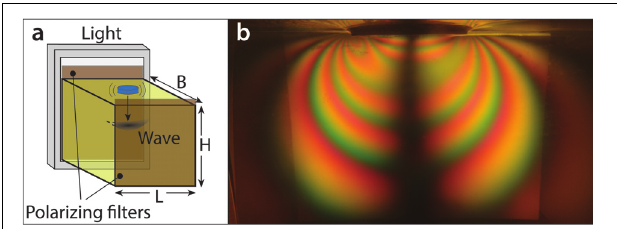
FIGURE 1 | (a) Experimental setup. We arrange a block of gelatin with a set polarizing filters, one in front and one behind the block of gelatin. Light passes through the setup and the deviatoric stresses become apparent. We used tanks of different shapes and dimensions, indicated below in the methodology section. A small plastic disk (blue object) is placed on the surface and struck to generate shear waves from the same location each time. (b) The photoelastic behavior of gelatin. In this example, a surface load generates a deviatoric stress field, which appears as a repeating rainbow pattern. The spacing of these rainbow fringes indicates the stress gradient. This particular visualization of the stress field is for illustration only, and does not correspond to an experiment analyzed in this